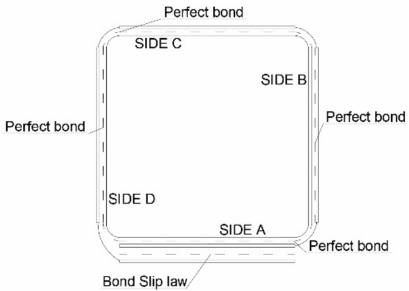
Figure 4. Scheme of interaction.